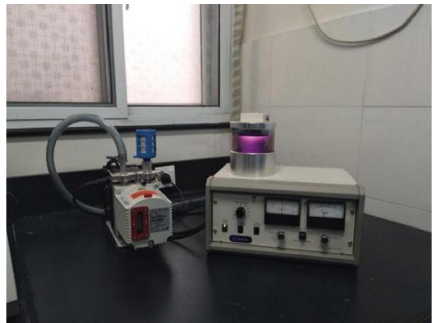
Figure 14: Vacuum gold plating process.